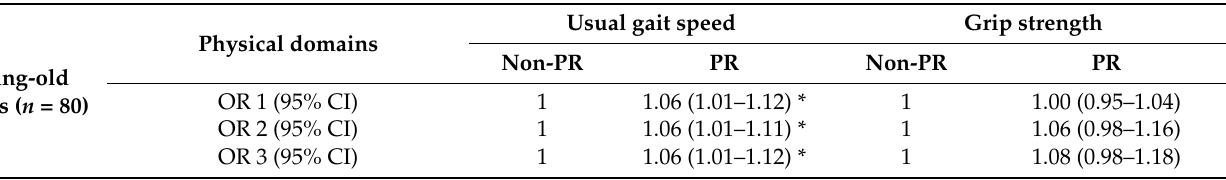
Table 3. Odds ratios and 95% confidence intervals for productive roles according to frailty by age